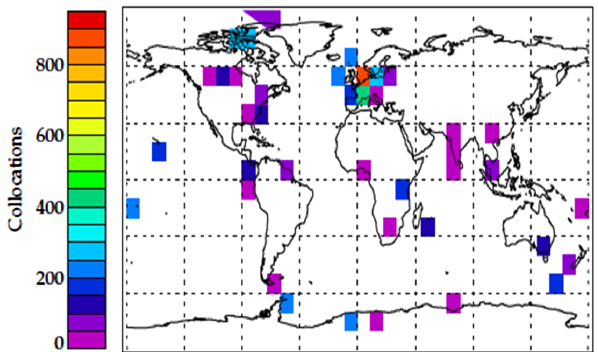
Figure 5. Geographical distribution of ozonesondes and numbers of GOME-2 profile collocations from 2007–2008 in 10 degree